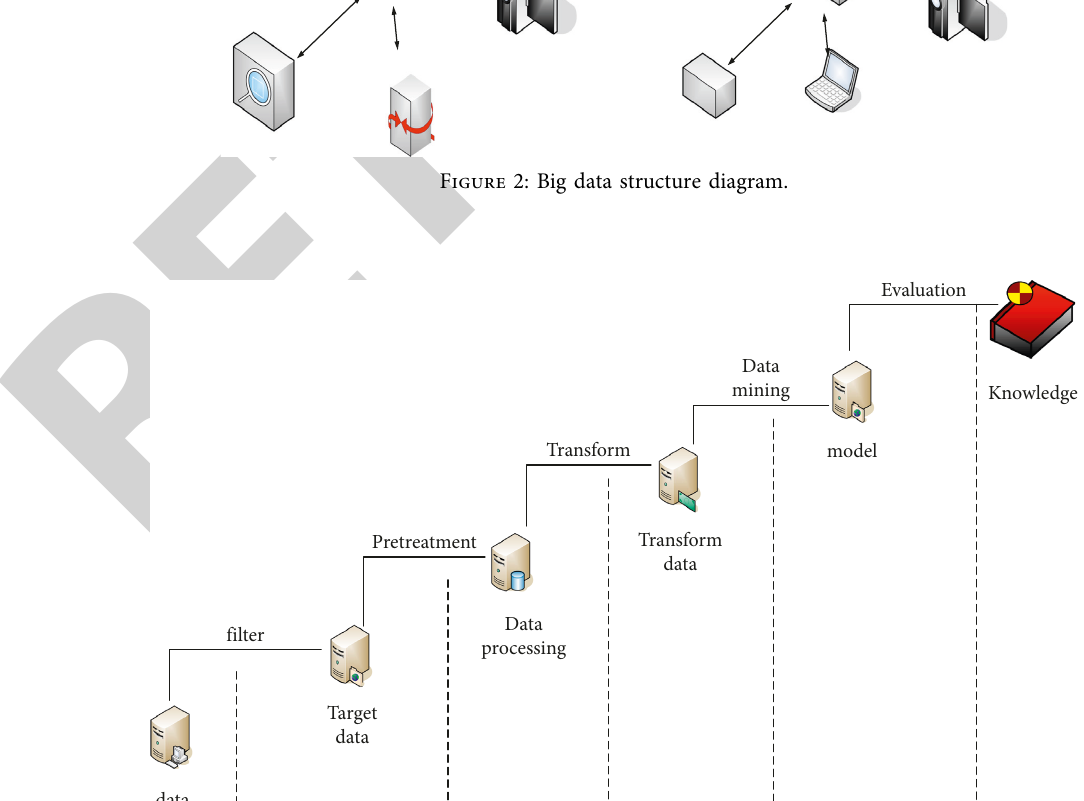
Figure 2: Big data structure diagram.